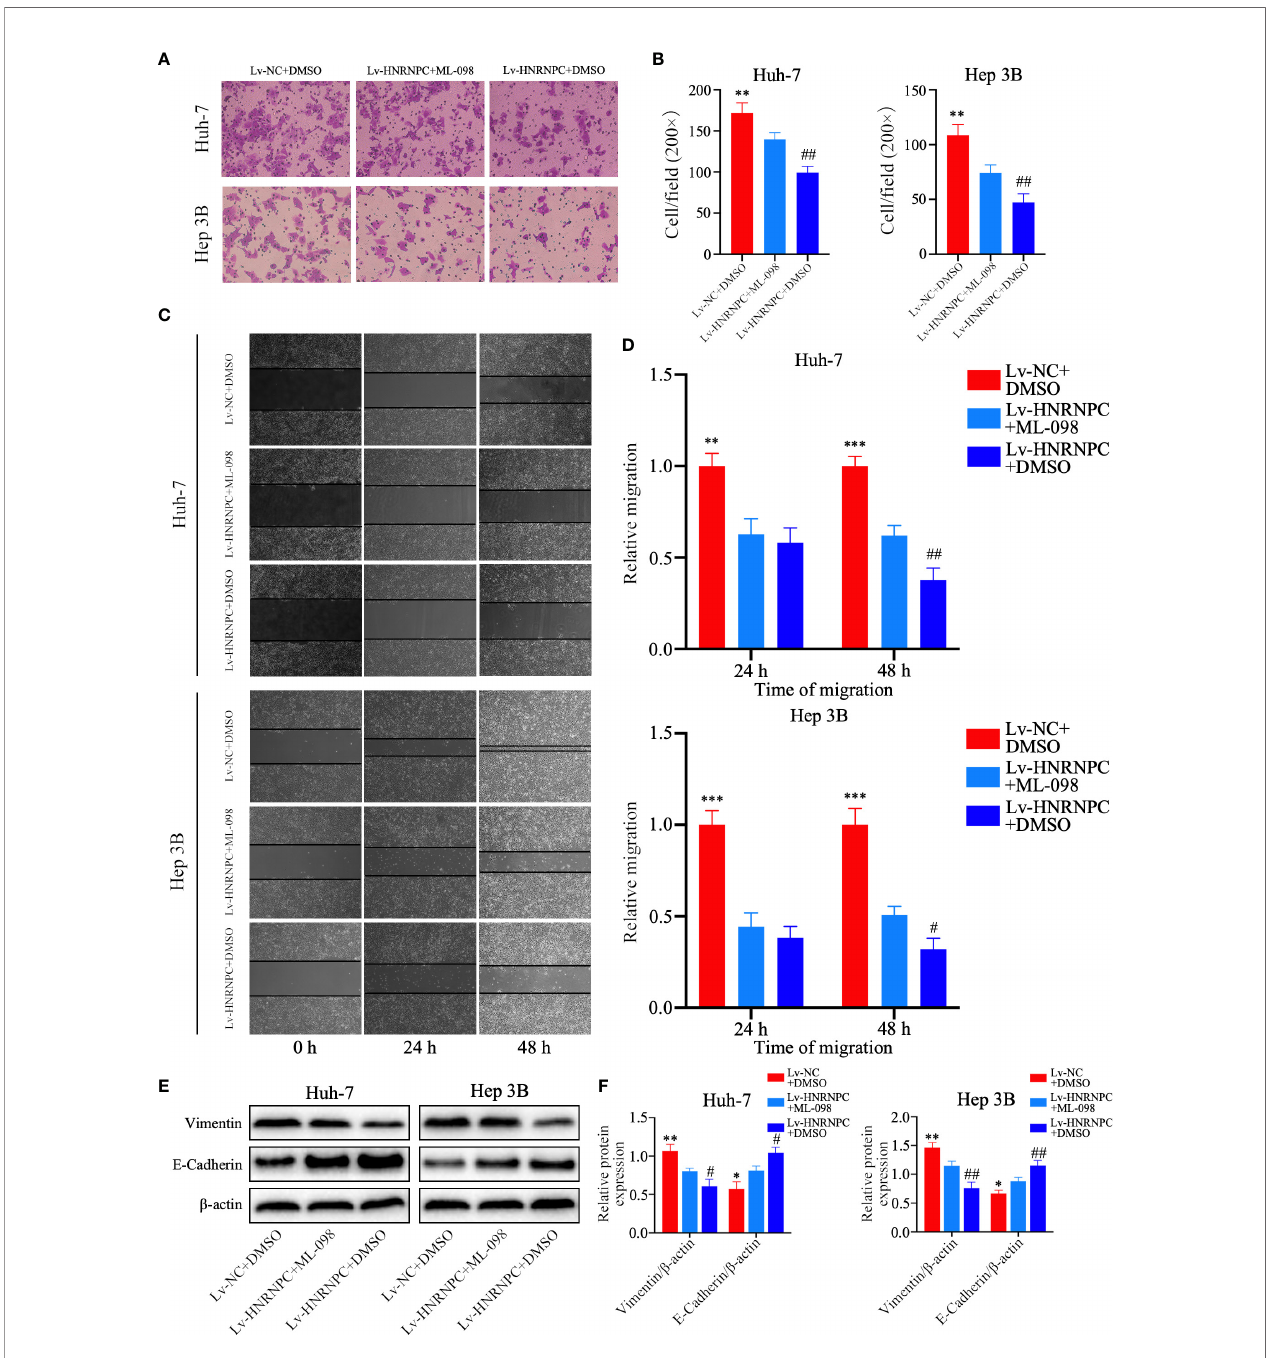
FIGURE 7 | ML-098 recovered the invasion and migration abilities of Lv-HNRNPC group cells in part. (A, B) Transwell assay demonstrating the recovered ef fi ciency of ML-098 in Lv-HNRNPC group cell invasion. (C, D) Scratch wound test showing the rescue by ML-098 of cell migration in the Lv-HNRNPC group. (E, F) Western blot to detect the recovery of EMT process in Lv-HNRNPC cell groups after treatment with ML-098. Each test was repeated independently in triplicate, and the results were demonstrated as mean ± standard deviation (SD). *P < 0.05, **P < 0.01, ***P < 0.001, for Lv-NC+DMSO group compared with Lv-HNRNPC+ML-098 group; # P < 0.05, ## P < 0.01, for Lv-HNRNPC+DMSO group compared with Lv-HNRNPC+ML-098